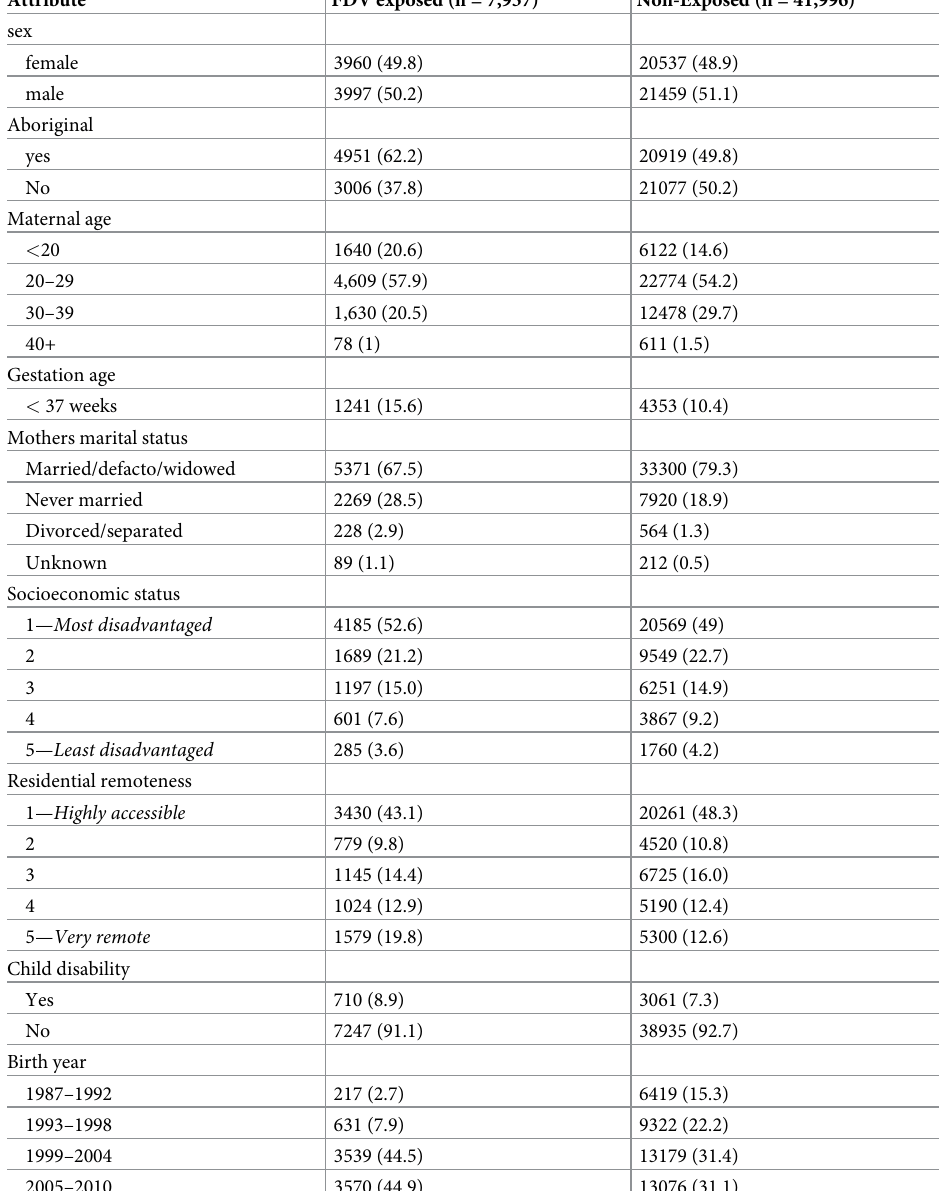
Table 1. Demographic characteristics of the study